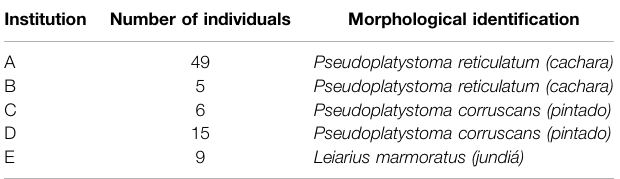
TABLE 1 | Institution of origin, number of individuals and morphological (phenotypic) identi fi cation of all samples analyzed in the current study. Institution Number of